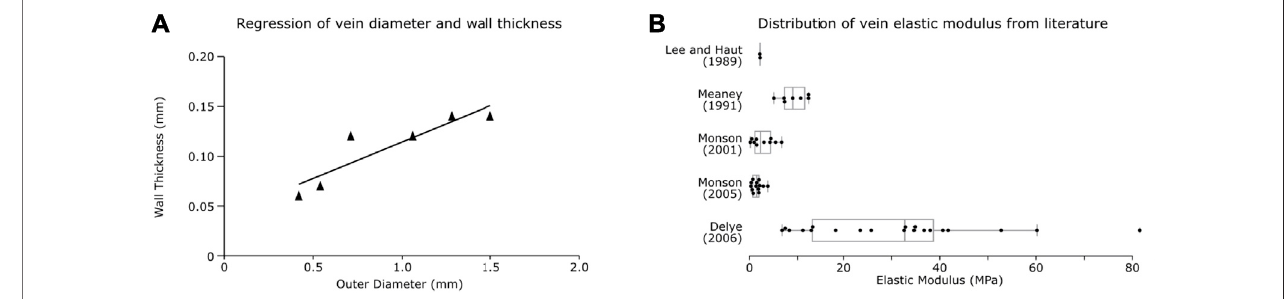
FIGURE 2 | Vein properties. (A) Regression plot for vein wall thickness based on outer diameter from Monson (2001). (B) Box plots of vein elastic modulus calculated from individual test data found in